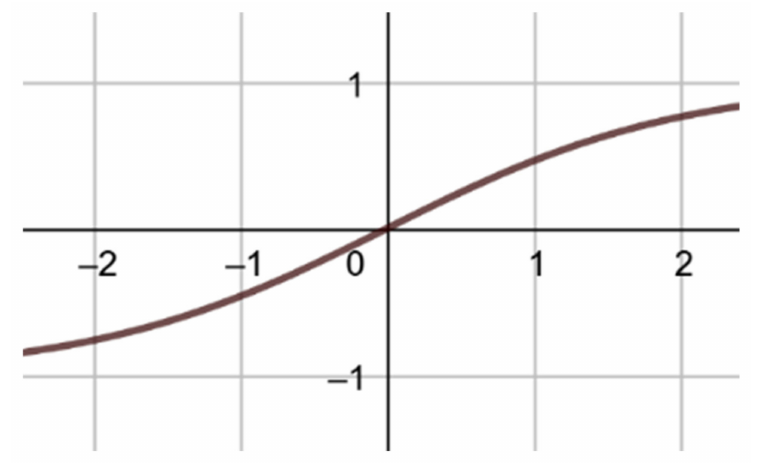
Figure 3. TanSigmoid Function.